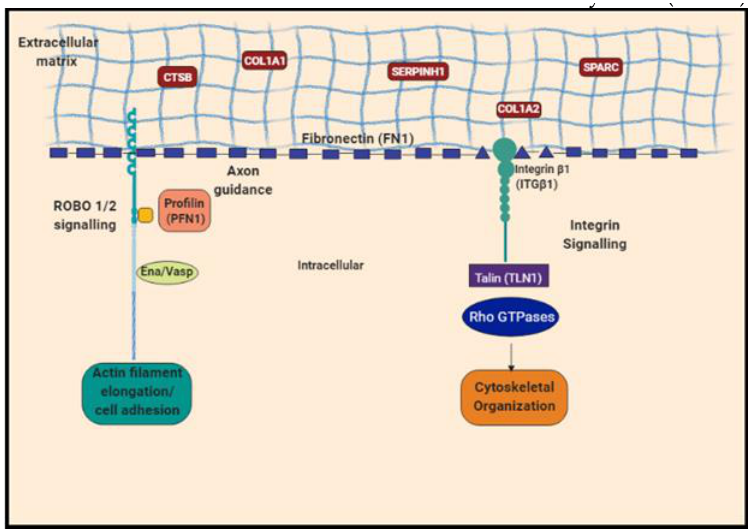
Figure 7. Schematic representation of key proteins involved in axon guidance, ROBO signaling and in- tegrin signaling regulating the actin filament elongation/cell adhesion and cytoskeletal